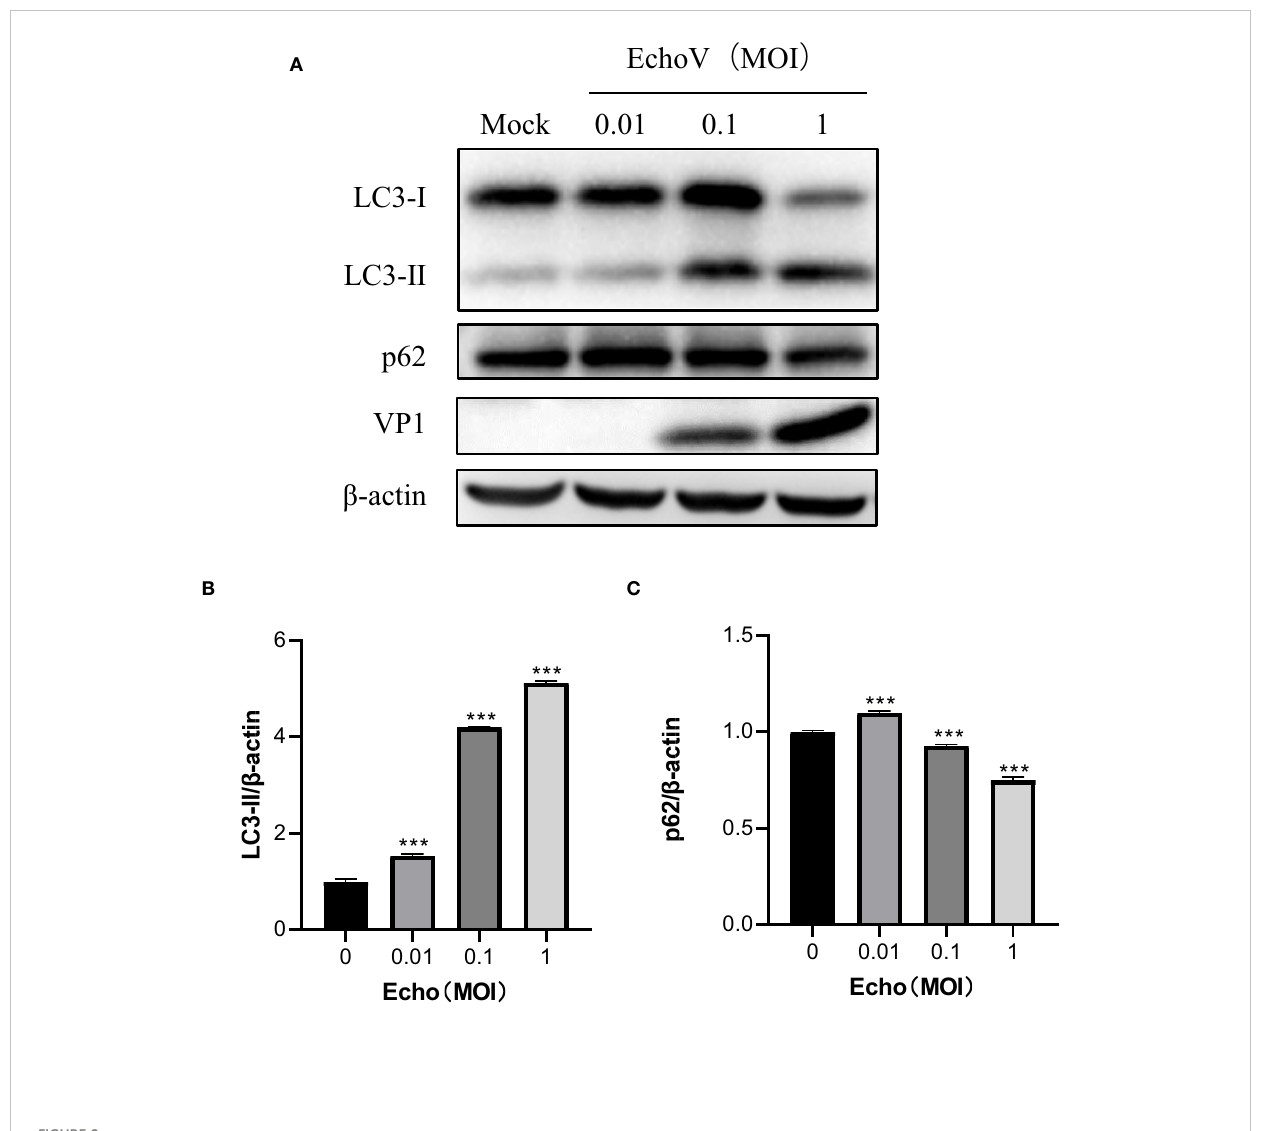
FIGURE 2 Echovirus infection induced-autophagy is positively correlated with viral load. RD cells were infected or not (Mock) with echovirus 11 at different MOI for 1.5 h. At 16 h post-infection, cells were then harvested. (A) Intracellular LC3 and p62 proteins were detected via western blotting. b -actin